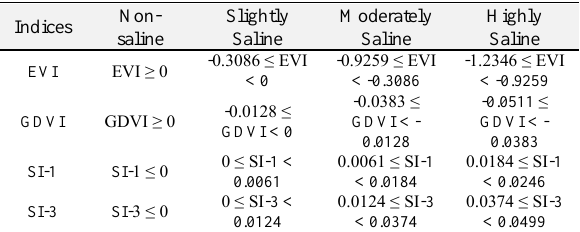
Table 3. Ranges of salinity classes for slope maps of optimal